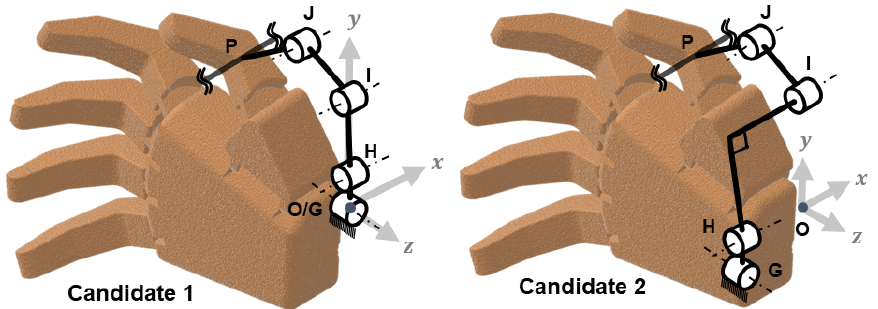
Figure 10. Difference of each candidate and configuration of the third chain for each candidate. (The actual distance between joint H and G is